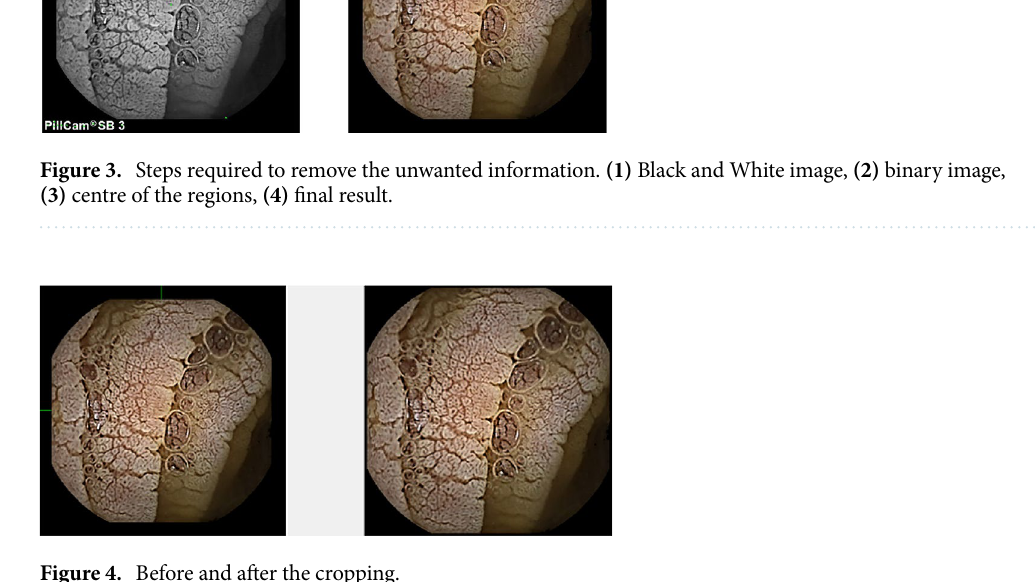
Figure 4. Before and after the